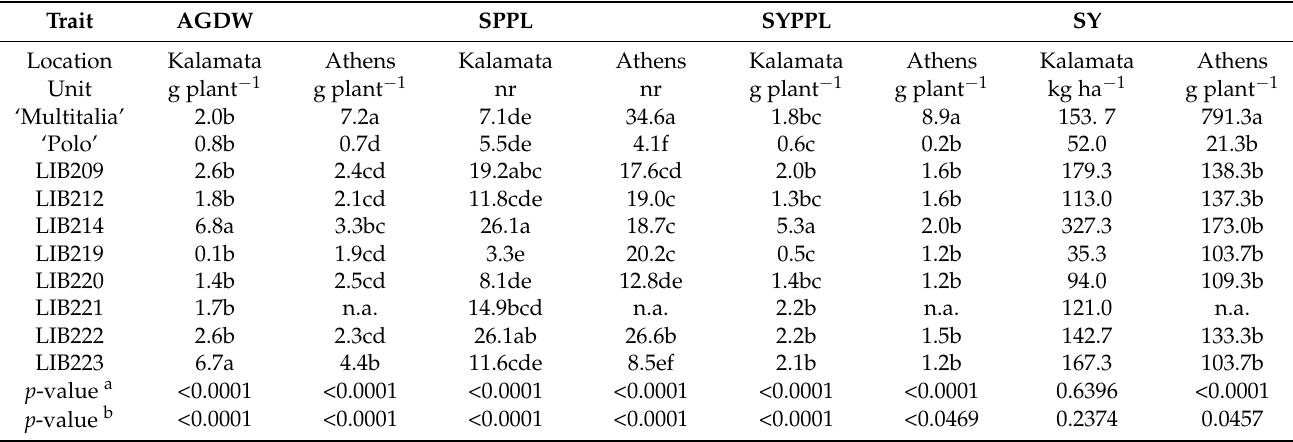
Table 5. Yield traits among L. mutabilis accessions and between locations in comparison to white (‘Multitalia’) and narrow- leafed lupin